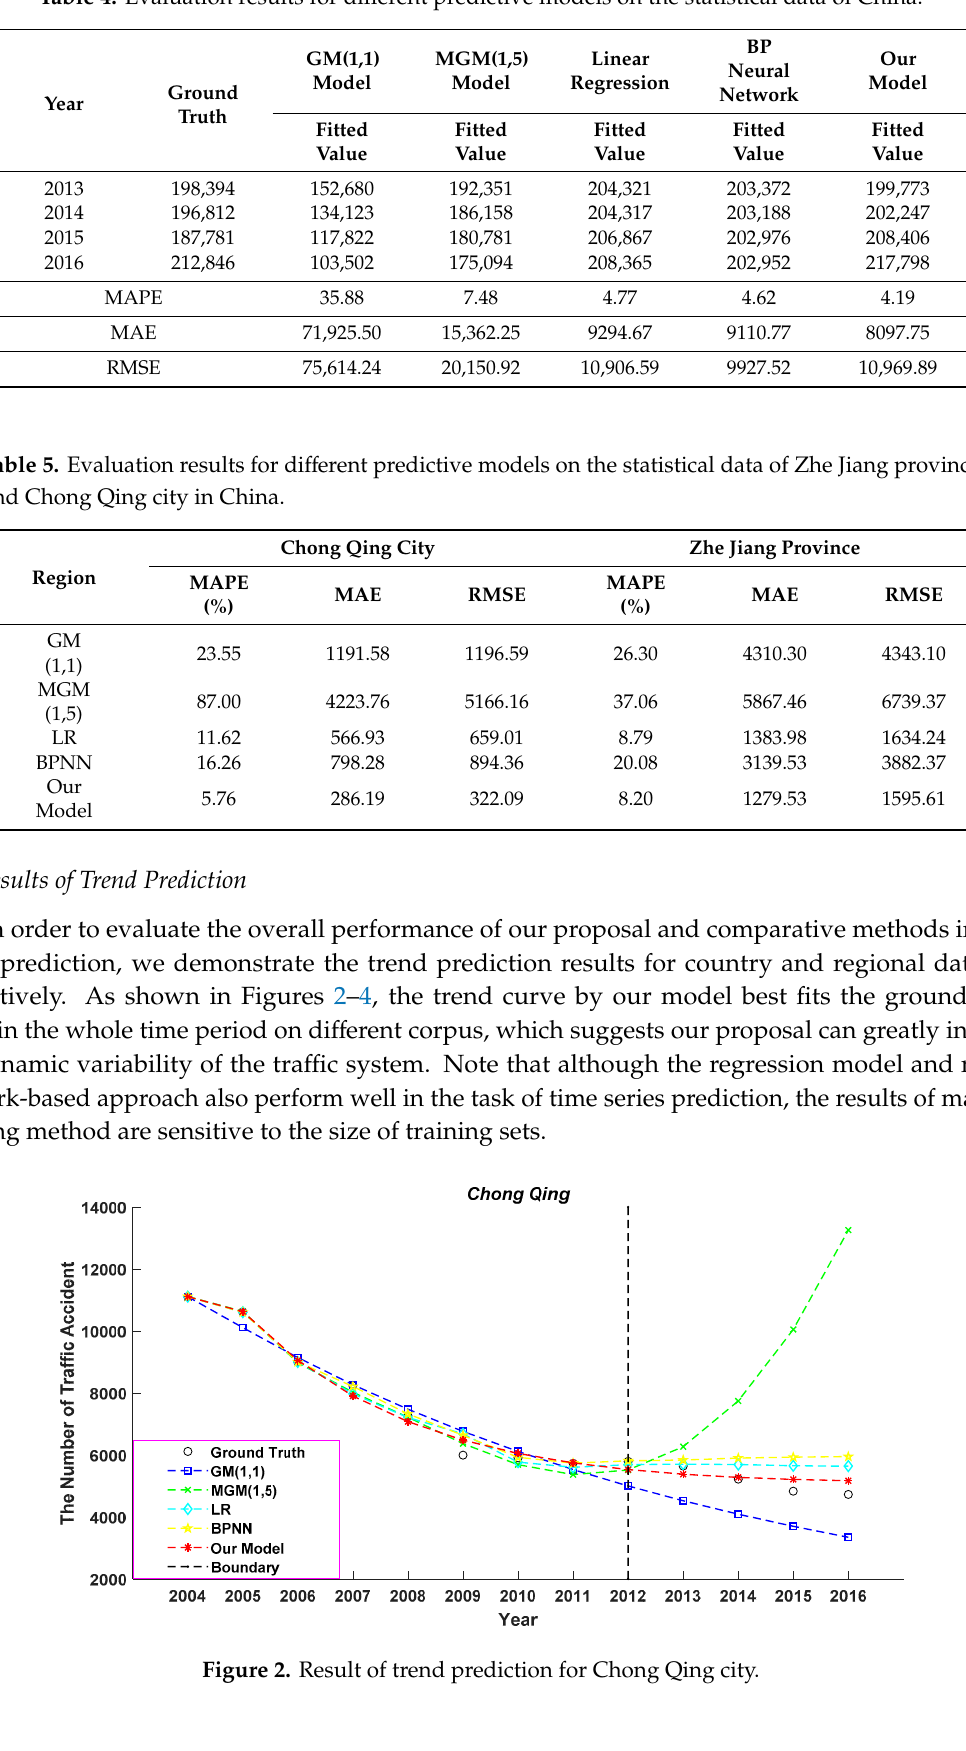
Table 4. Evaluation results for di ff erent predictive models on the statistical data of China.